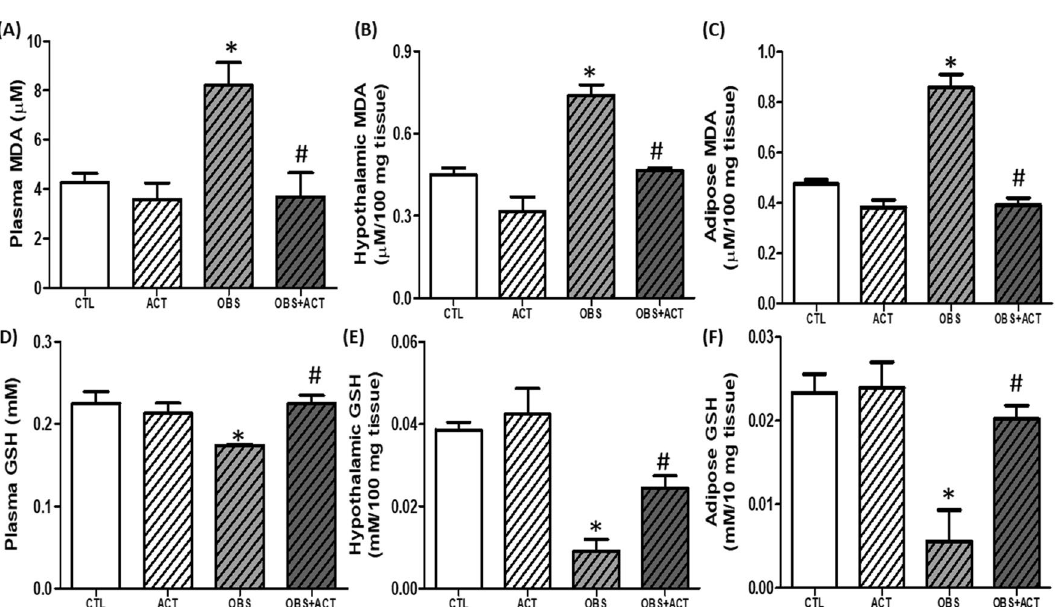
Figure 6. Effects of acetate on plasma, hypothalamic and adipose malondialdehyde ( A – C ) and glutathione ( D – F ) in high fat diet-induced obese Wistar rats. Plasma, hypothalamic and adipose MDA increased while glutathione decreased in obese rats, which were attenuated following the administration of acetate. Data are expressed as mean ± SD. n = 6 and analyzed by one-way ANOVA followed by Bonferroni post hoc test. (* p < 0.05 vs. CTL; # p < 0.05 vs. OBS). CTL Control, OBS Obesity, ACT Acetate, MDA Malondialdehyde, GSH